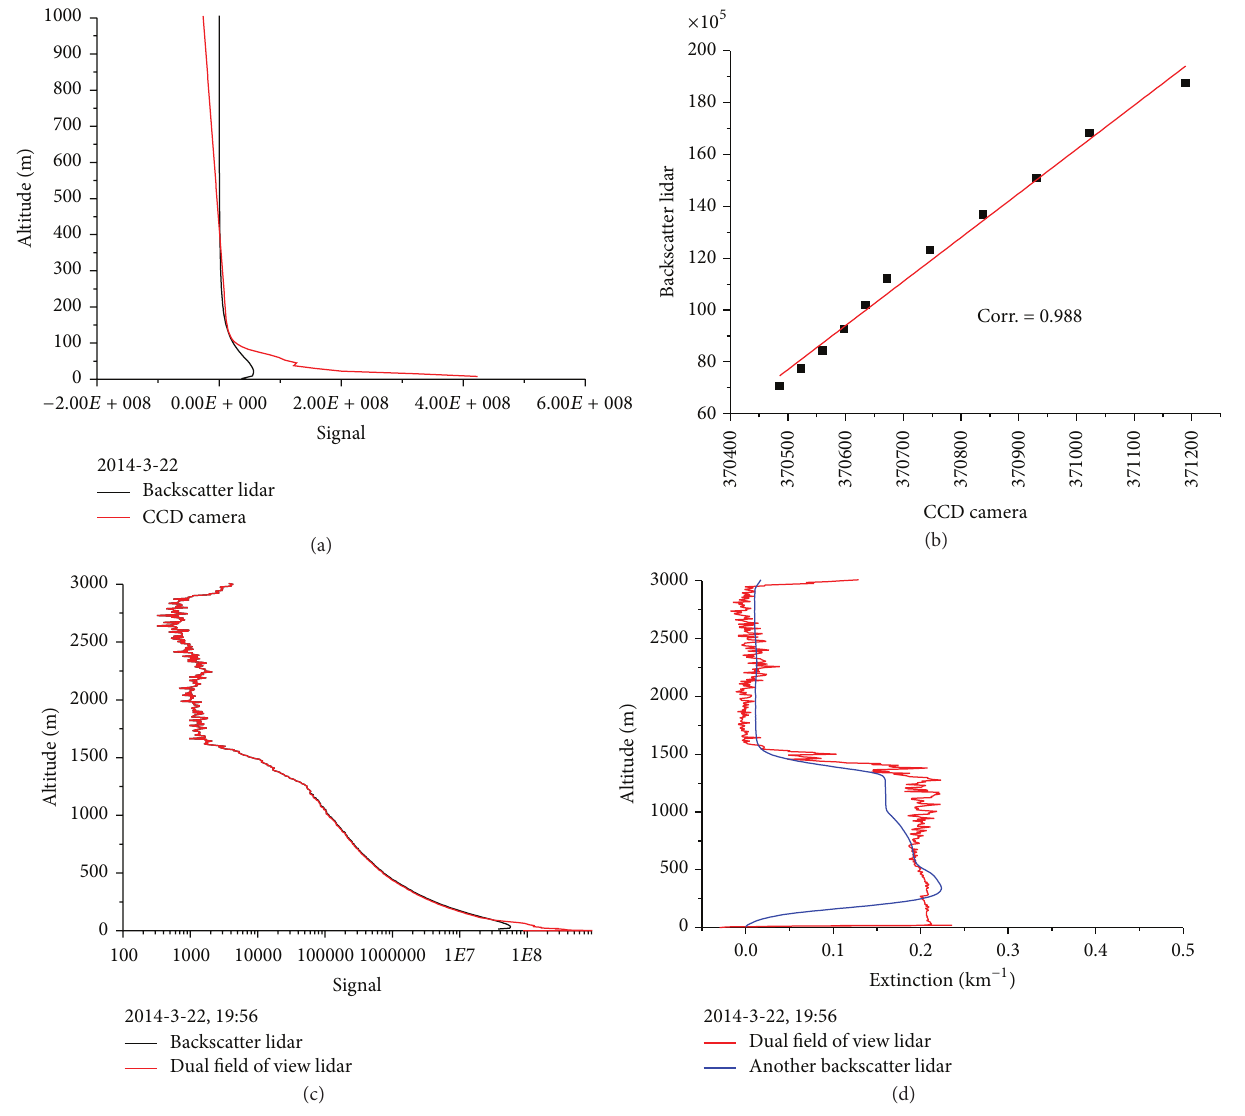
Figure 5: (a) The original signals received by the two receivers of the dual field of view lidar. (b) The correlation analysis in the range of 220–300 m. (c) Comparison of the gluing signal and original backscatter lidar signal received by the telescope. (d) Comparison of extinction coefficient